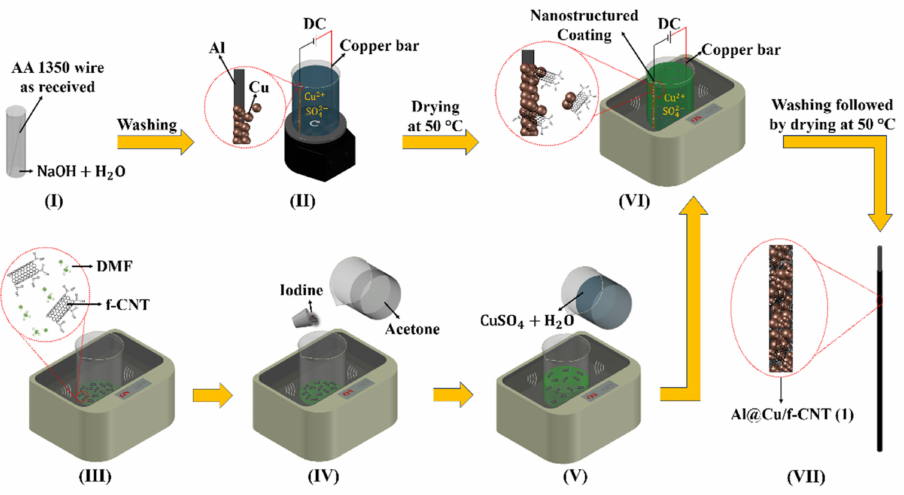
Figure 1. Schematic illustration of AA 1350 wire-coating process with